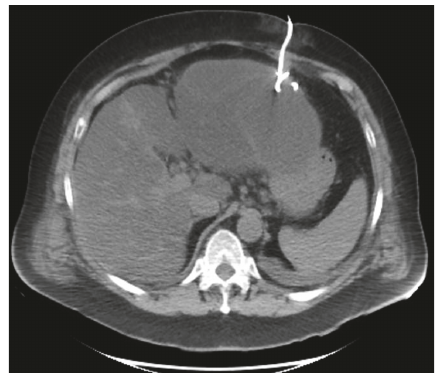
Figure 4: CT abdomen demonstrating subcapsular collection.